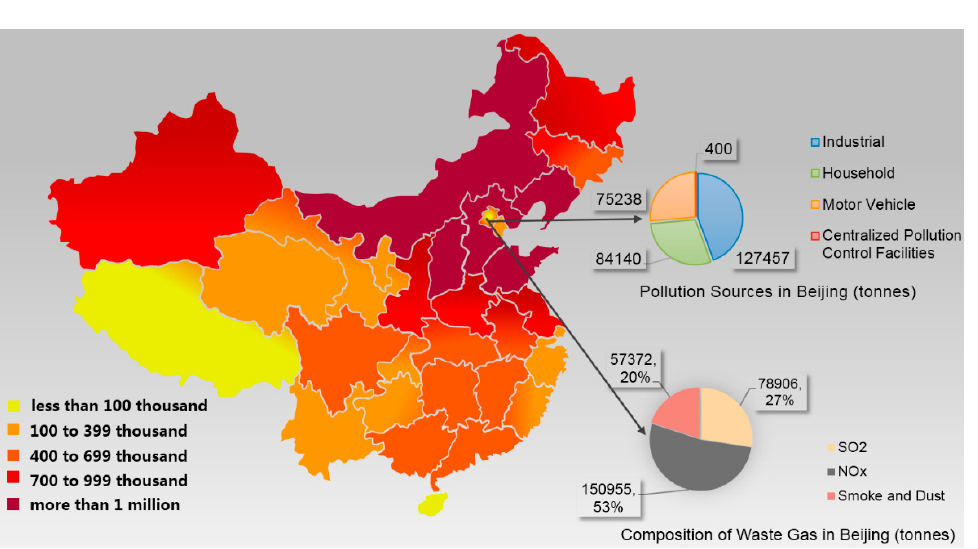
Figure 1. Waste gas emissions in Chinese districts in 2014 (tons) [8].